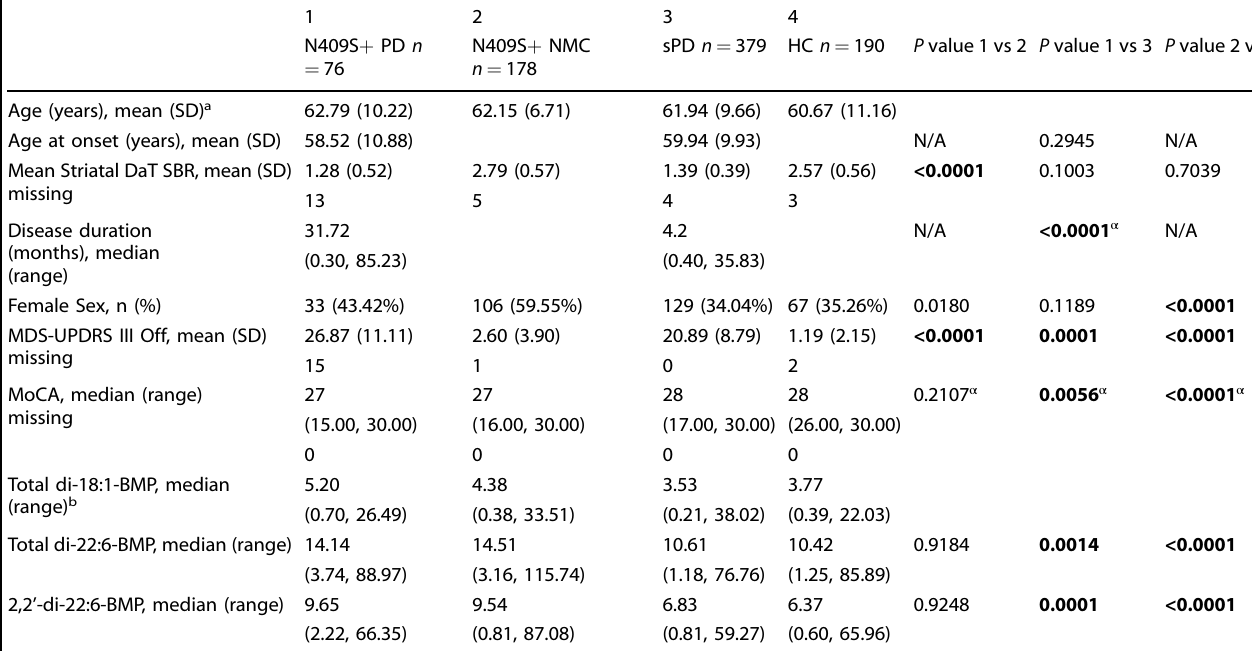
Table 3. Baseline demographics, clinical characteristics, mean striatal DaT SBR and BMP concentrations (adjusted for age and sex) in GBA1 N409S + PD, N409S + NMC, sPD, and